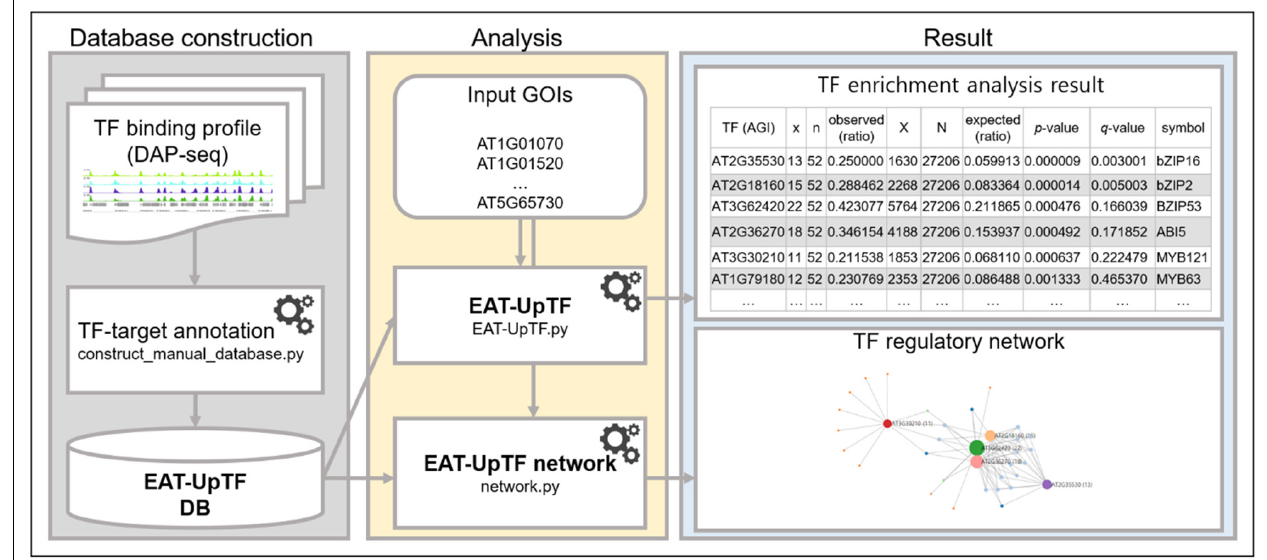
FIGURE 1 | Workflow of EAT-UpTF. Manual database can be constructed based on binding profiles of multiple TFs generated by DAP-seq and ChIP-seq using manual database construction module (construct_manual_database.py). When a set of genes of interest (GOIs) is input along with database, EAT-UpTF performs enrichment analysis and shows the overrepresented upstream TFs for the GOIs. Network construction module (network.py) also visualizes regulatory networks of TFs and their target genes.